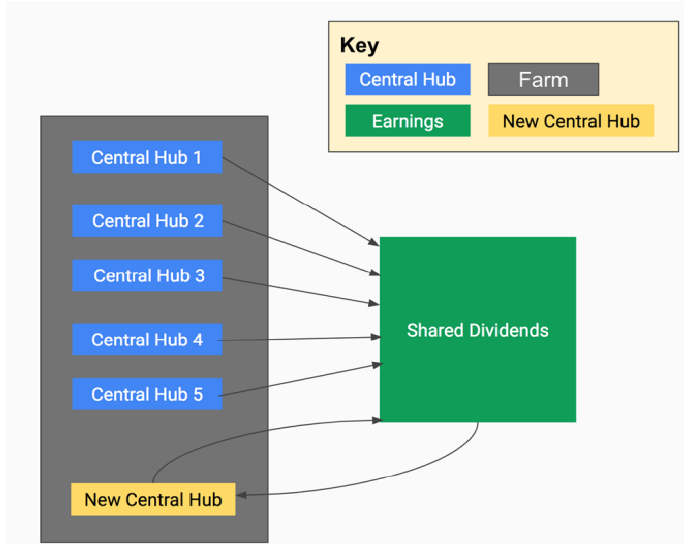
Fig. 1. Model for staking coins for scientific funding. The term masternodes is interchangeable with central